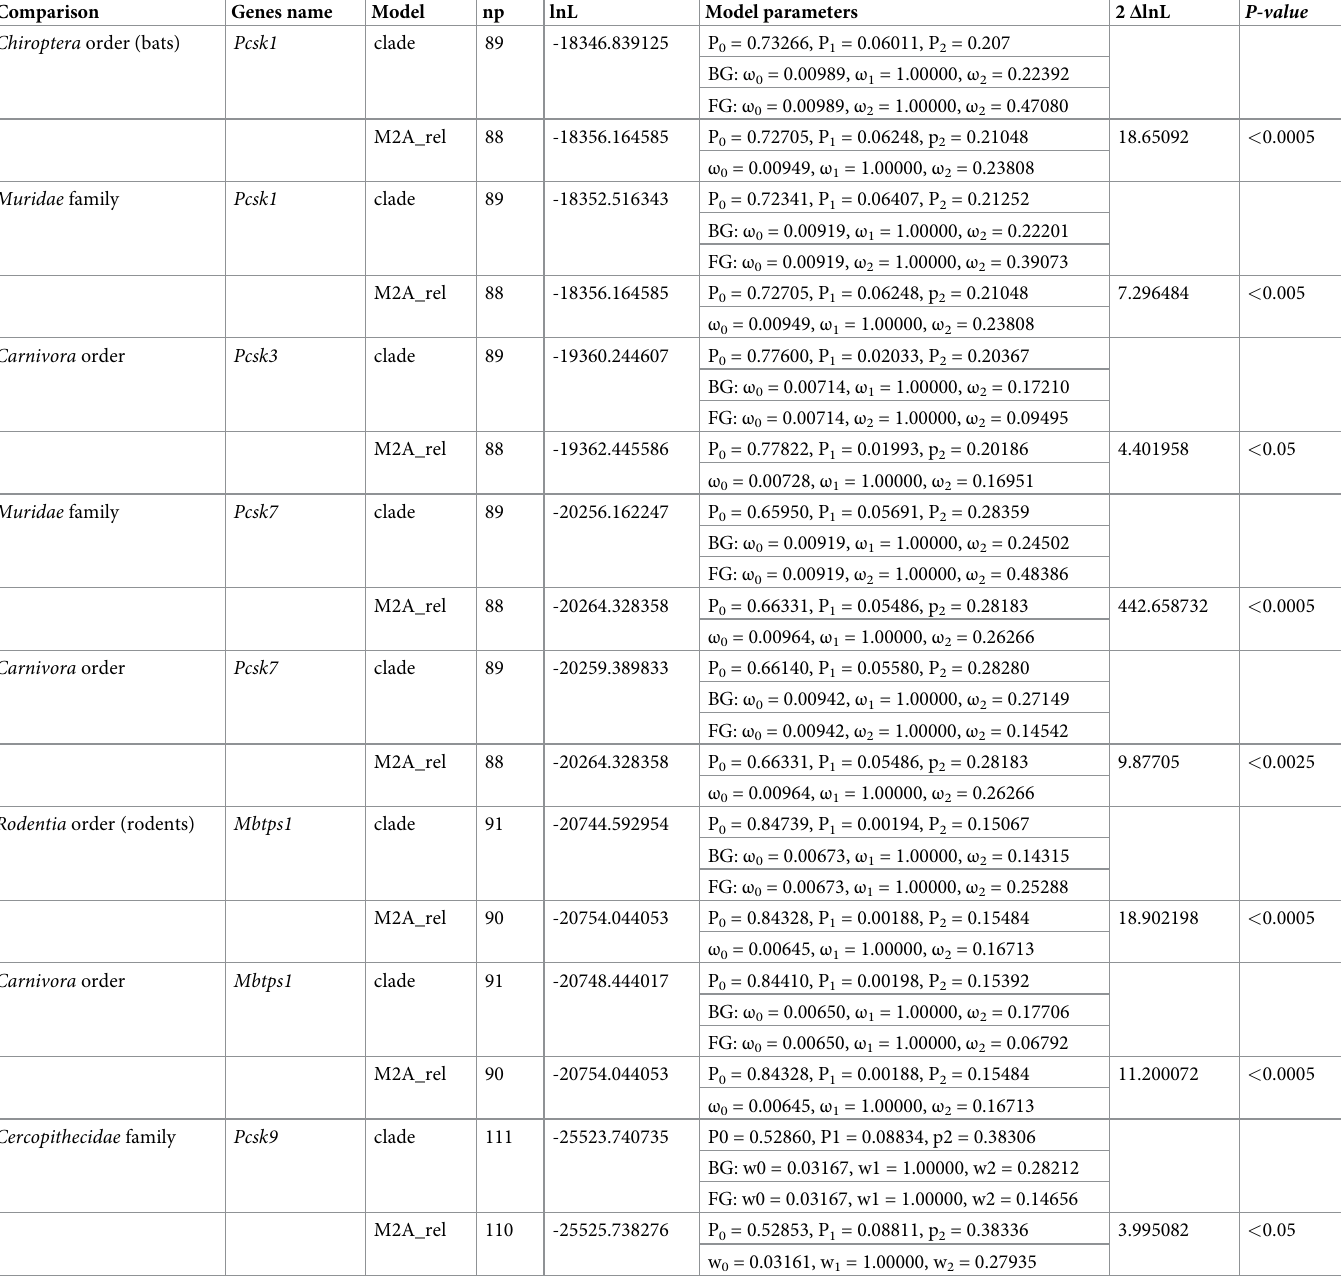
Table 2. Parameter estimates for pcsk1, pcsk3, pcsk7 and mbtps1 Clade model C and the result of LRT tests.